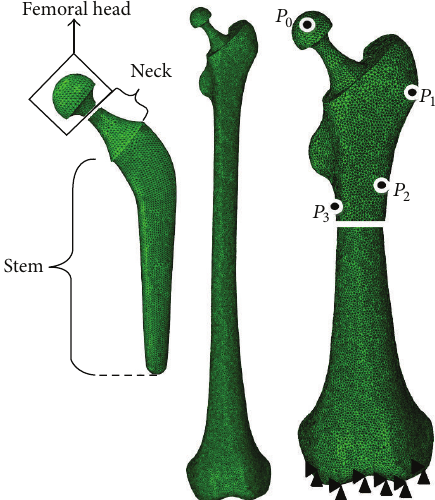
Figure 2: Mesh and boundary